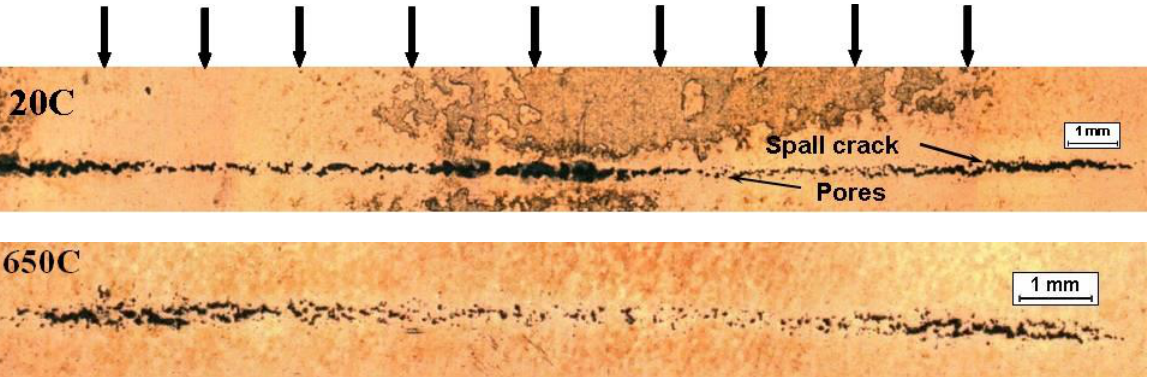
Figure 9. Micrographs of the spall zone of Inconel 718 alloy samples in the as-received state at room and elevated temperatures up to 650 °C. Thick black arrows indicate the direction of impact.